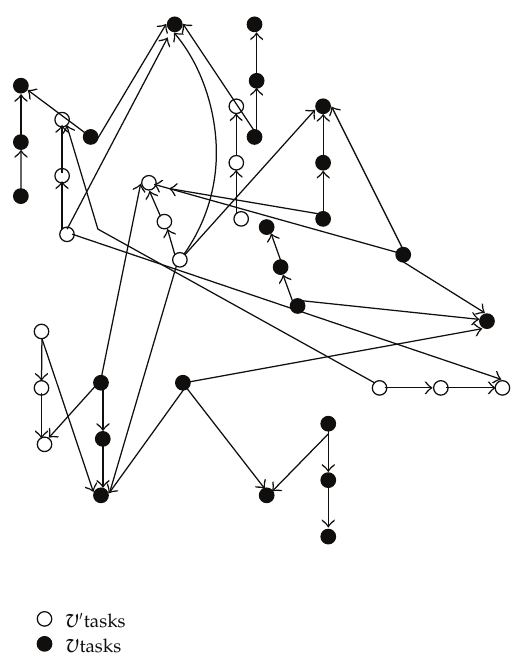
Figure 8: The final W graph issue from several